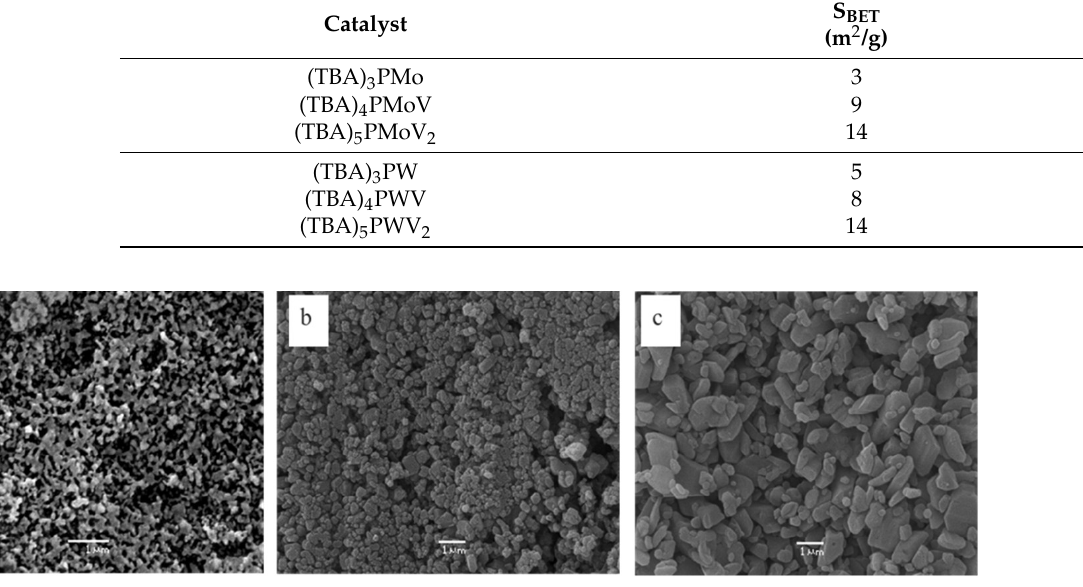
Figure 6. The SEM images of the Mo-series synthesized materials: ( a ) (TBA) 3 PMo, ( b ) (TBA) 4 PMoV, ( c ) (TBA) 5 PMoV 2 .